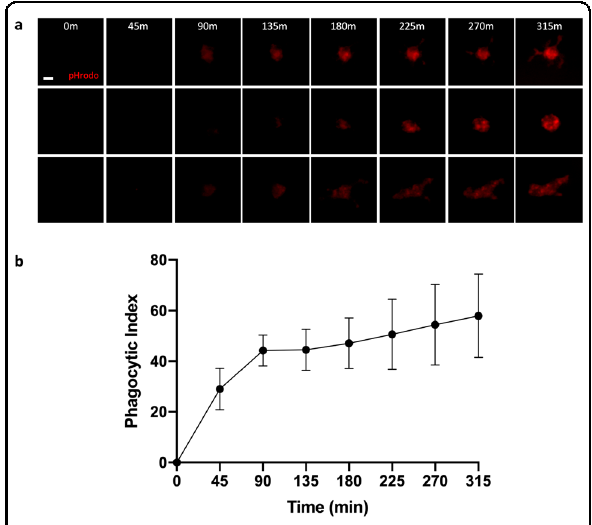
Fig. 3 Quantifying synaptosome engulfment by CB-iMGs using live real-time imaging. a Representative pHrodo (red)-labeled synaptosome engulfment in iMG cells during live real-time imaging used for quanti fi cation Scale bar: 20 μ m. b Quanti fi cation of labeled synaptosome uptake by CB-iMGs cells during live imaging. The phagocytic index represents the mean pHrodo + area per iMG cell over N = 8 fi elds per well × 3 wells per line and N = 4 separate healthy control CB-IMG line derivations. Error bars represent